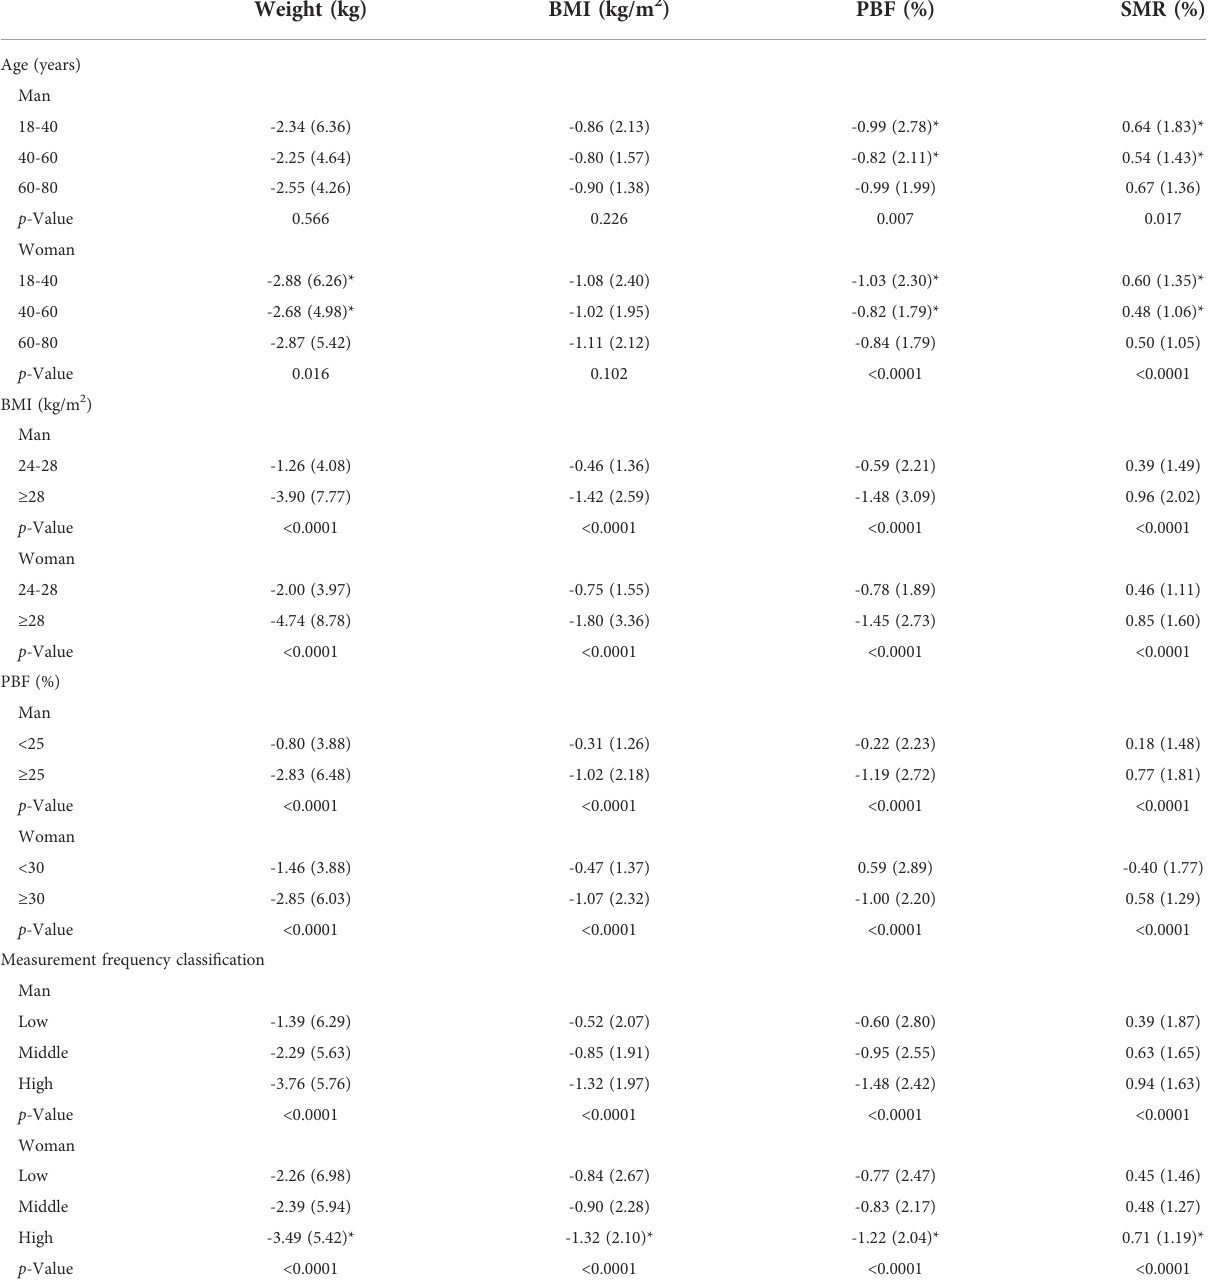
TABLE 2 Changes of obesity-associated body composition associated with baseline